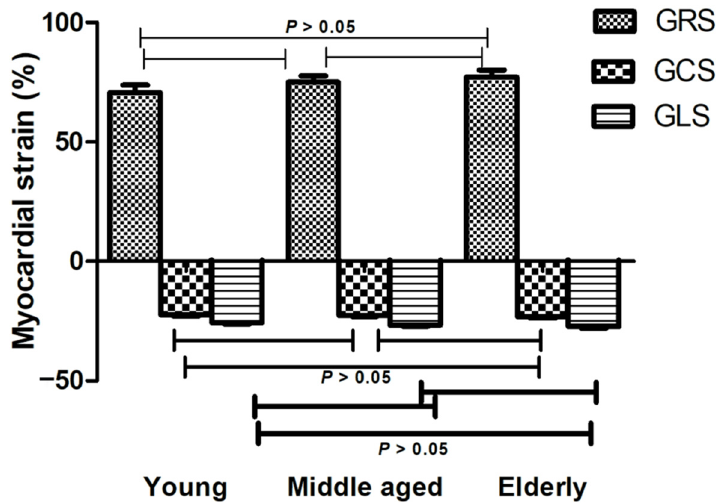
Figure 6. Myocardial strain in different age groups. There was no significant difference in global myocardial strain among all age groups. GRS: global radial strain; GCS: global circumferential strain; GLS: global longitudinal strain.